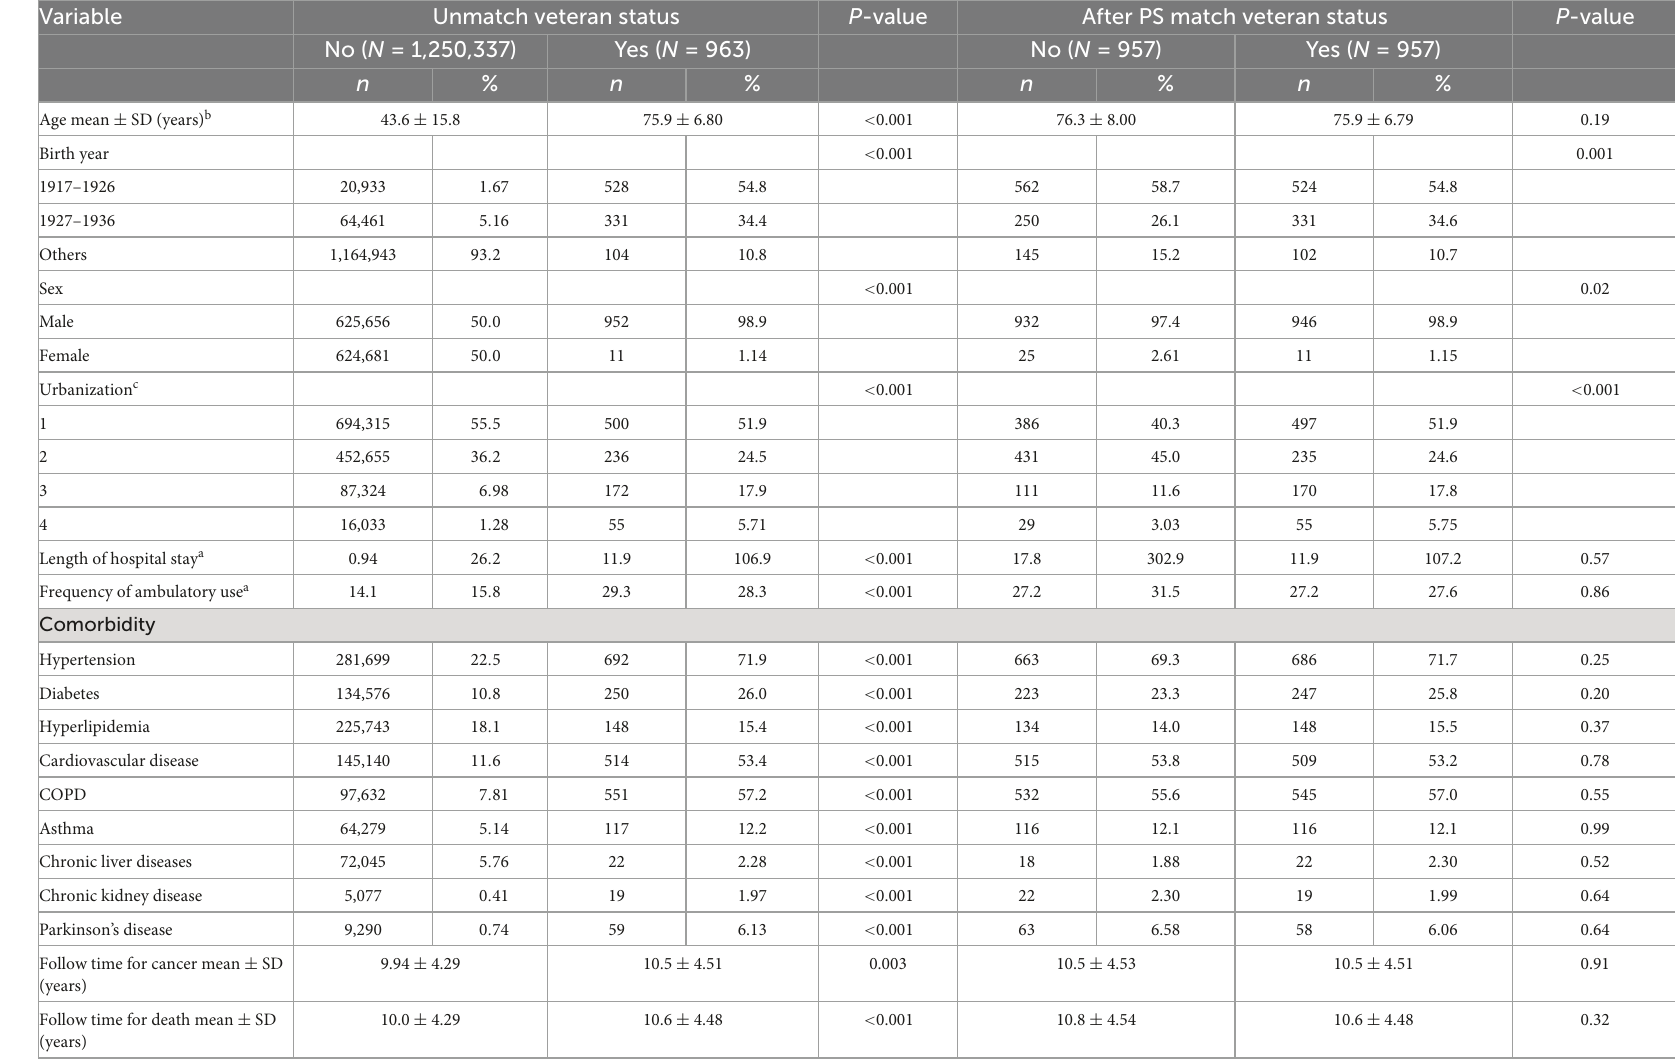
TABLE 1 Demographic characteristics of groups with and without veteran